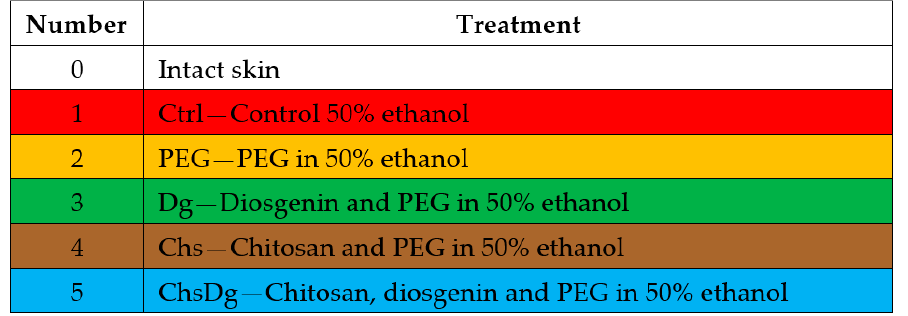
Figure 8. Scheme of the wounds treatment .